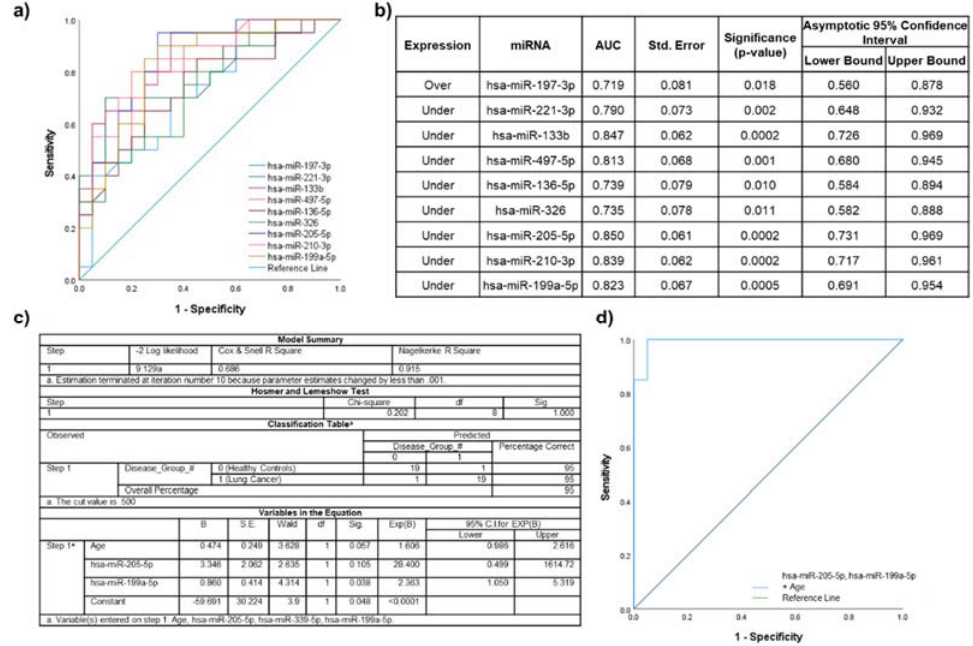
Figure 4. Discriminatory power assessed using ROC curves for the miRNAs that were significantly dysregulated in lung cancer participants compared to healthy non-smoker participants. ( a ) Individual ROC curves for under- and overexpressed miRNAs; ( b ) AUC values, including standard error (Std. Error), significance and 95% confidence intervals; ( c ) binary logistic regression model for miR-205-5p, miR-199a-5p, and significant clinical characteristic (age); ( d ) ROC curve for the logistic regression model.